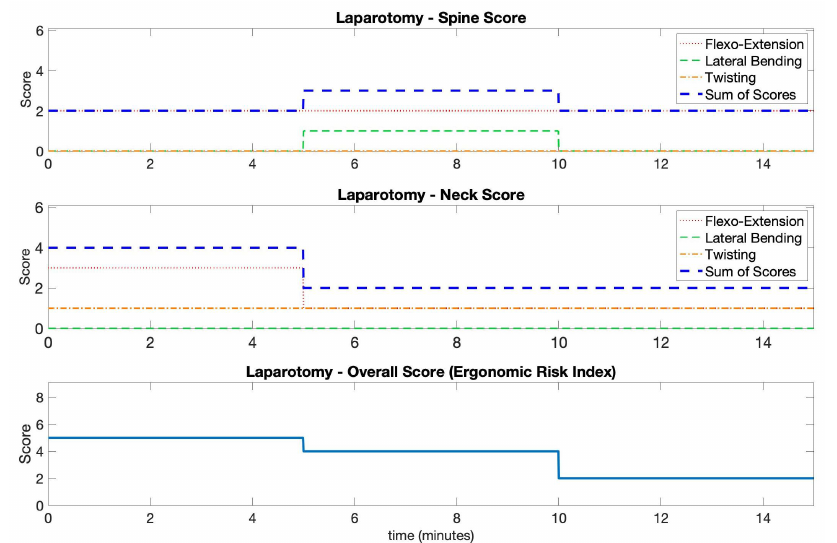
Figure 9. In this figure, the scoring results of the laparotomy procedure are reported. The partial and total scores for the trunk and head, as well as the final score, obtained using the table in Figure 2, are